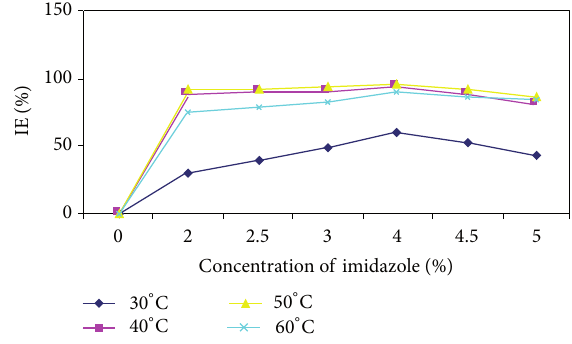
F 1: Inhibition efficiency of Imidazole at various